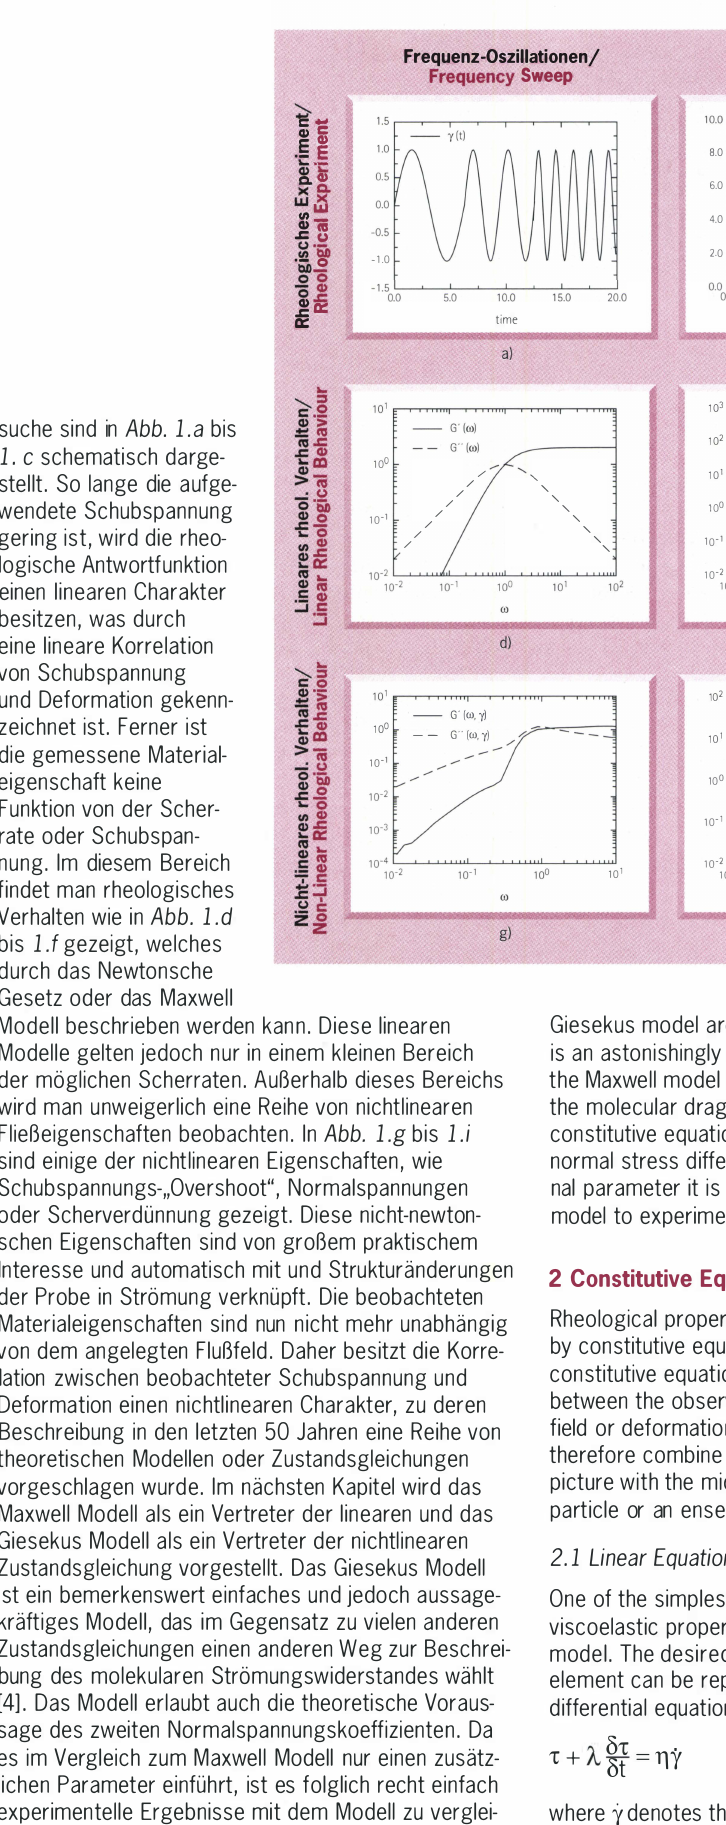
model to experimental results.